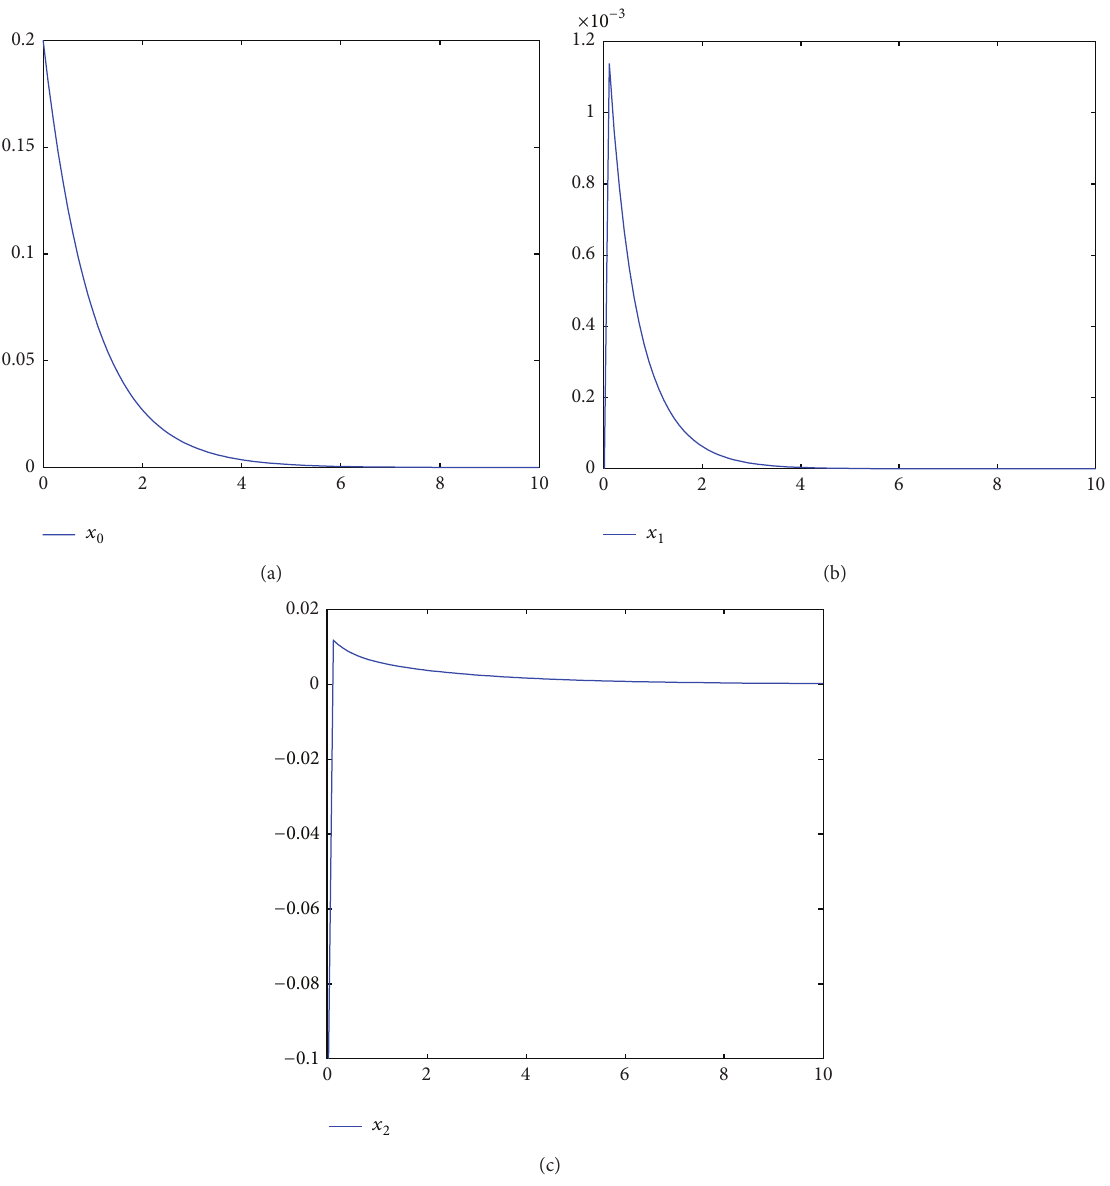
Figure 1: States 𝑥 0 (𝑡),𝑥 1 (𝑡),𝑥 2 (𝑡)